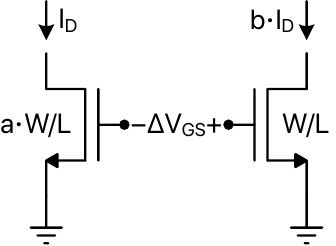
Figure 3. MOSFET pair for ∆ V GS signal